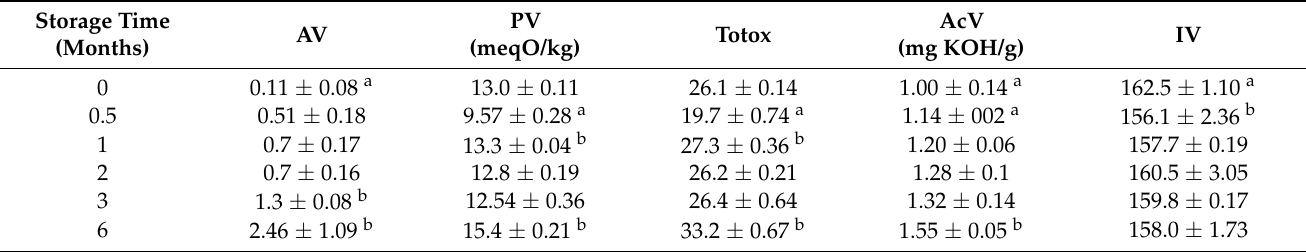
Table 4. Anisidine value (AV), peroxide value (PV) Totox, acid value (AcV) and iodine value (IV) of sage macerate after various storage times at refrigeration temperature (4 ◦ C).